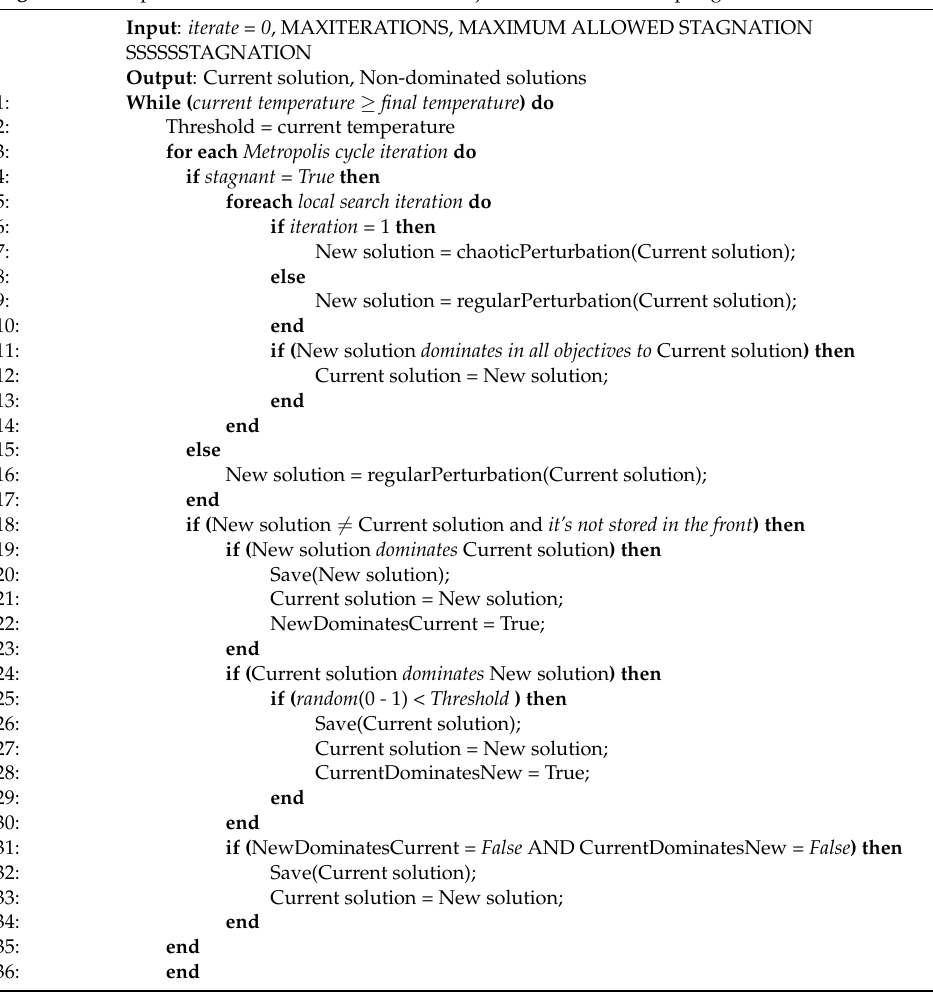
Algorithm 4. Improvement method: Chaotic Multi-Objective Threshold